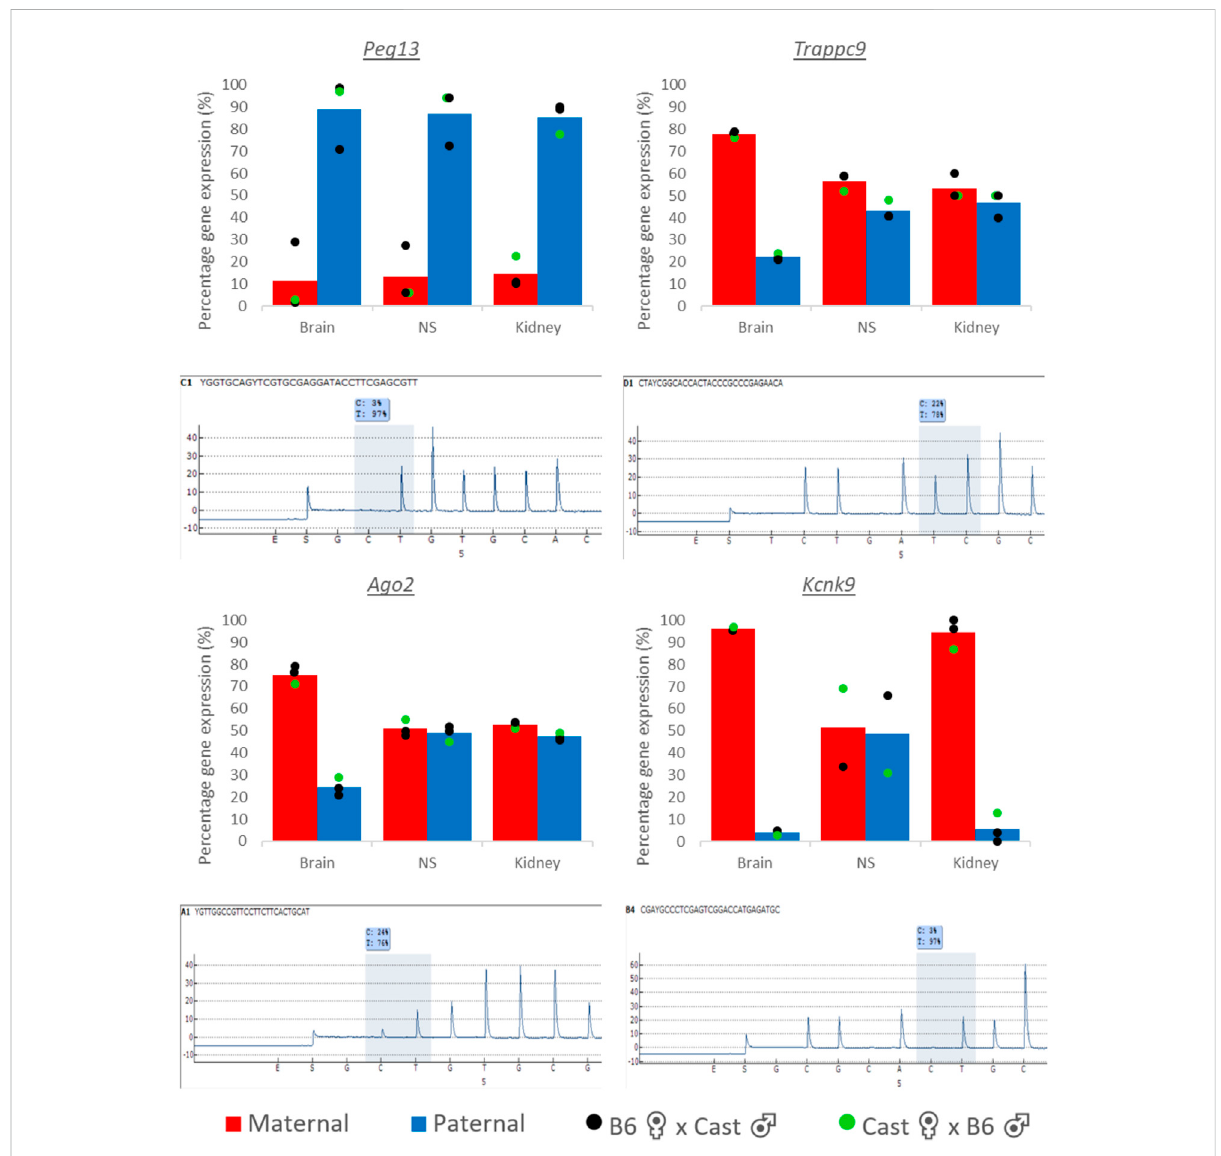
FIGURE 2 Allelic expression in tissues and primary hippocampal neurospheres of hybrid mice. Parental allelic expression was quanti fi ed via SNP pyrosequencingofcDNAfromtissuesorculturedneurospheres(NS)obtainedfromnewbornmice.Averageexpression( n =2 – 3)andexampletraces are shown. SNP IDs and exon locations are: Peg13 (rs238259968 and rs31423566 located in exon 1), Trappc9 (rs31440851 located in exon 2), Ago2 (rs232384843 located in exon 5) and Kcnk9 (rs225149059 located in exon 1). Points on the bar graphs represent individual pyrosequencing results from reciprocal crosses as shown in the legend. For Peg13 each data point shows the average of the two SNP values in the same sequence read. Representative pyrograms from whole brain samples are shown, indicating the SNP position in the sequence and the quanti fi cation of allelic